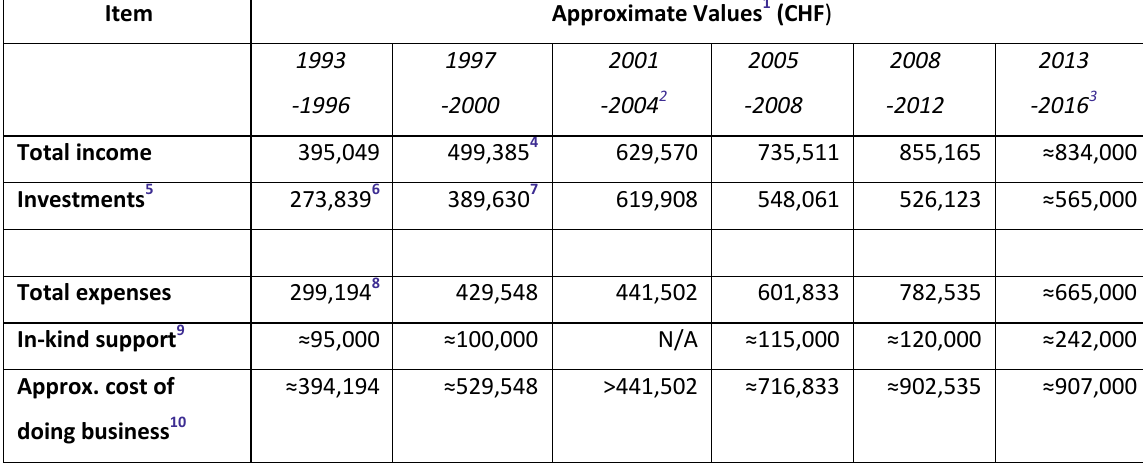
Table 4: Cost of doing business for